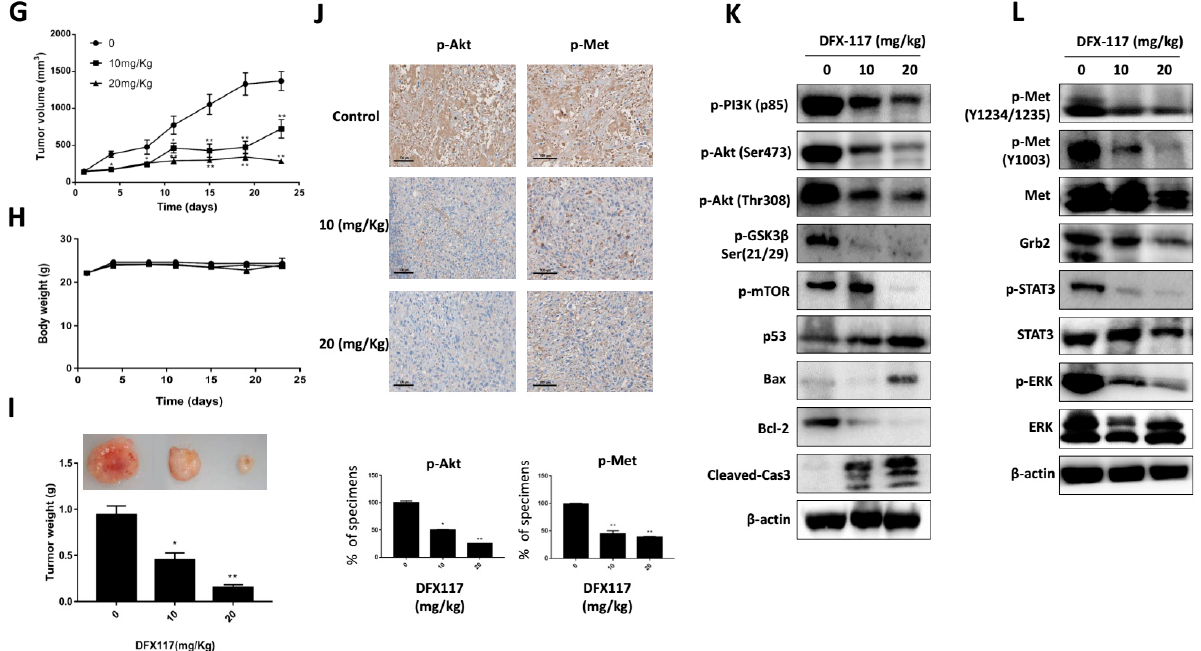
Figure 6. DFX117 inhibited tumor growth in a nude mouse xenograft model. ( A – C ) 3 × 10 6 cells (A549) were subcutaneously injected into nude mice. Mice were orally administered DFX117 (5 mg/kg, 10 mg/kg and 20 mg/kg) or the vehicle control (DMSO: polyethylene glycol: saline = 1:5:4) daily for 23 days after tumor volumes reaching to 100 mm 3 around. Tumor volumes were measured with calipers and body weights were monitored every 2–3 days. Data represent the means ± SEM ( n = 5). ( D ) Determination of the alteration of p-Akt (Ser473), p-Met, Ki67 and cleaved caspase 3 in tumor tissues (A549 xenograft). The changes of the related proteins were evaluated by immunohistochemical analysis. Each tissue section was incubated with the indicated antibodies and analyzed by immunohistochemical method described in the Materials and Methods. ( E , F ) The effects of DFX117 on the expression levels of the corresponding proteins in Met/PI3K signaling in tumor tissues (A549 xenograft) were examined by Western blot analysis. ( G – I ) Mice bearing subcutaneously injected 7 × 10 6 cells (NCI-H1975) were orally administered DFX117 (10 mg/kg or 20 mg/kg) or the vehicle control (DMSO: polyethylene glycol: saline = 1:5:4) daily for 23 days. Tumor volumes were measured with calipers, and body weights were monitored every 2–3 days. Data represent the means ± SEM ( n = 5). ( J ) Immunohistochemical analysis of the expression level of p-Akt, p-Met in tumor tissues (NCI-H1975 xenograft). Each tissue section was incubated with the indicated antibodies and analyzed by immunohistochemical method described in the Materials and Methods. ( K , L ) The inhibition of DFX117 on Met/PI3K signaling in tumor tissues were analyzed by western blotting (NCI-H1975 xenograft). Data are representative of three independent experiments. Each bar represents the mean ± SEM ( n = 3). * p < 0.05 or ** p < 0.01 was considered statistically significant compared with the corresponding control values.